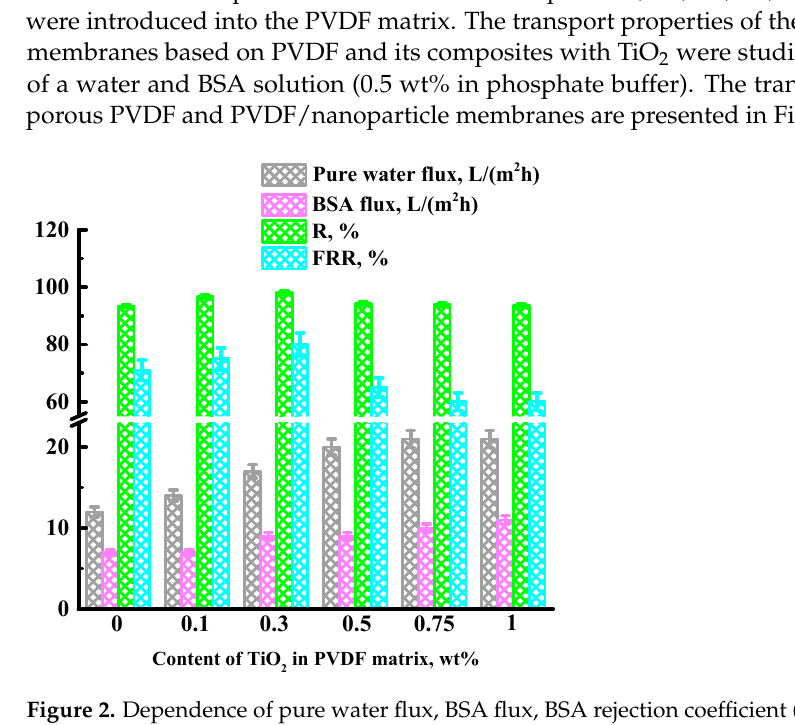
Figure 2. Dependence of pure water flux, BSA flux, BSA rejection coefficient (R), and flux recovery ratio (FRR) on the TiO 2 concentration in the PVDF matrix during BSA ultrafiltration at 1 bar. The ultrafiltration experiment was carried out over 2 h.